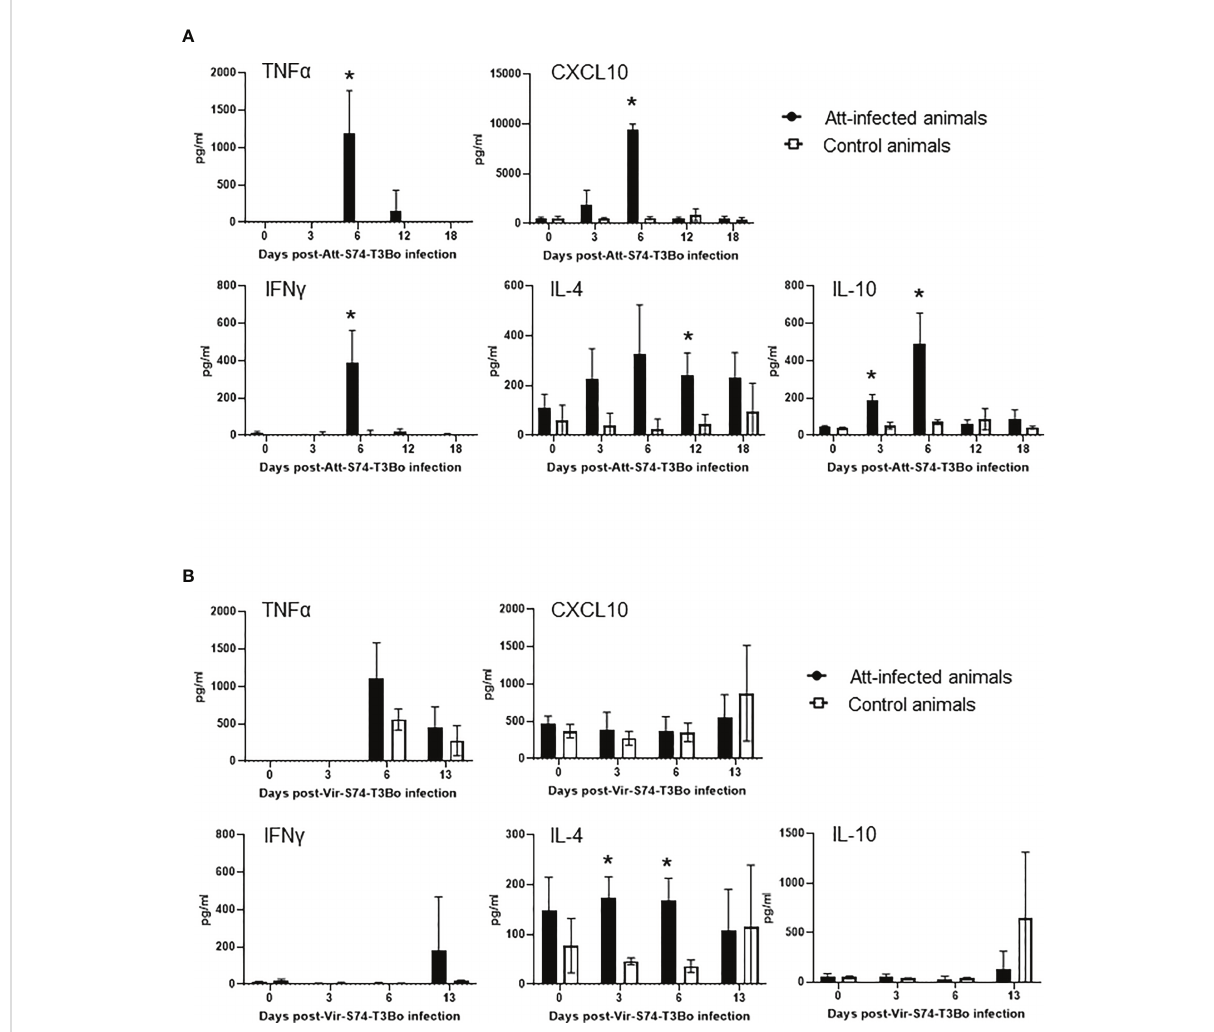
FIGURE 6 Presence of TNF a , CXCL10, IFN g , IL-4, and IL-10 in peripheral blood of cattle infected with the in vitro culture attenuated B. bovis strain Att-S74-T3Bo (A) following superinfection with the virulent B . bovis strain Att-S74-T3Bo (B) . Att infected animals (n=3). Control animals (n=3; two animals of the control group were humanely euthanized at days 13 and 14 after Vir-S74-T3Bo inoculation due to the severity of the disease). *